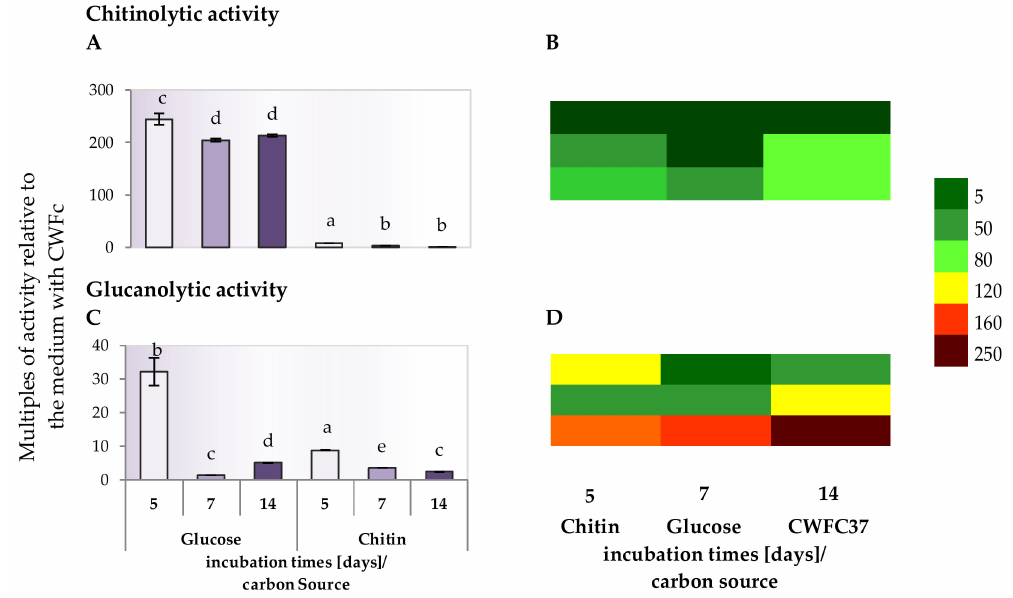
Figure 7. The multiples of chitinolytic ( A ) and glucanolytic ( C ) activity of Trichoderma DEMTkZ3A0 strain on medium supplemented with lyophilized cell wall of the pathogenic F. culmorum strain (CWFC37) relative to the medium with glucose or chitin. Heatmap allows to compare chitinolytic ( B ) and glucanolytic ( D ) activity on three carbon sources: Glucose, chitin and after 5, 7, and 14 days of incubation. The color scheme of the heat map fields represents the concentration in µ g /